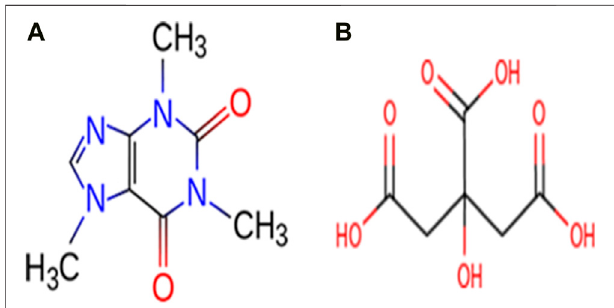
FIGURE 1 | Molecular structures of (A) Caffeine and (B) Citric